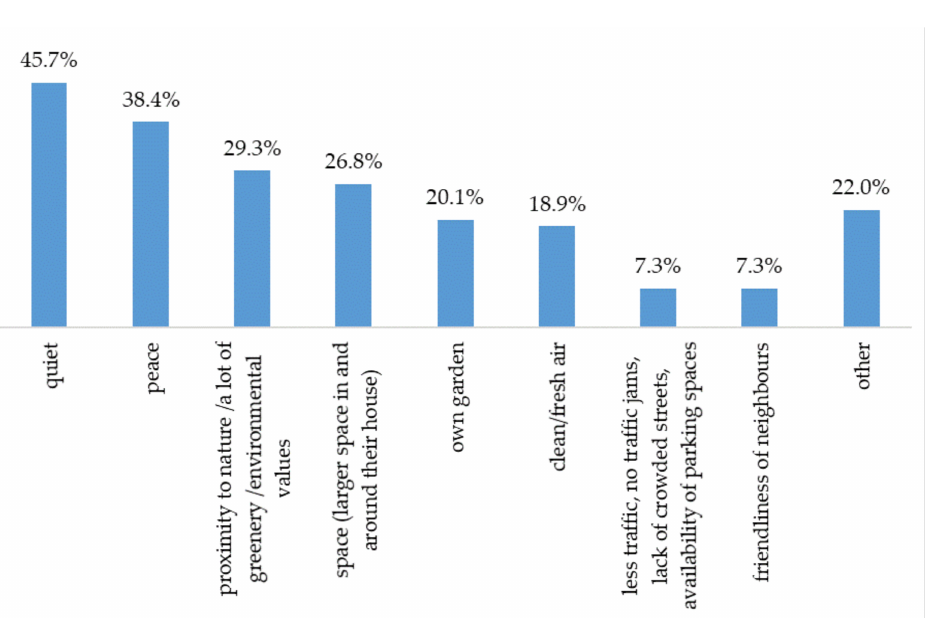
Figure 5. Elements of rural residence assessed most positively in relation to the previous place of residence. Source: own study based on research